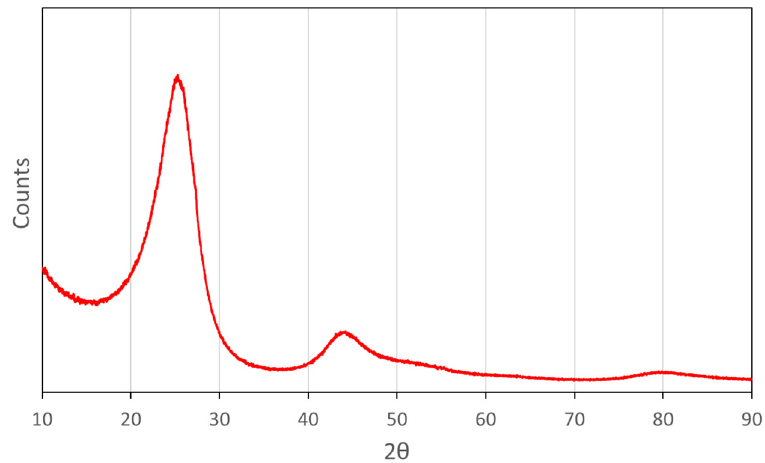
Figure 4. Results from XRD-analysis on the deposits on the heated filter after gasification at 1200 °C.